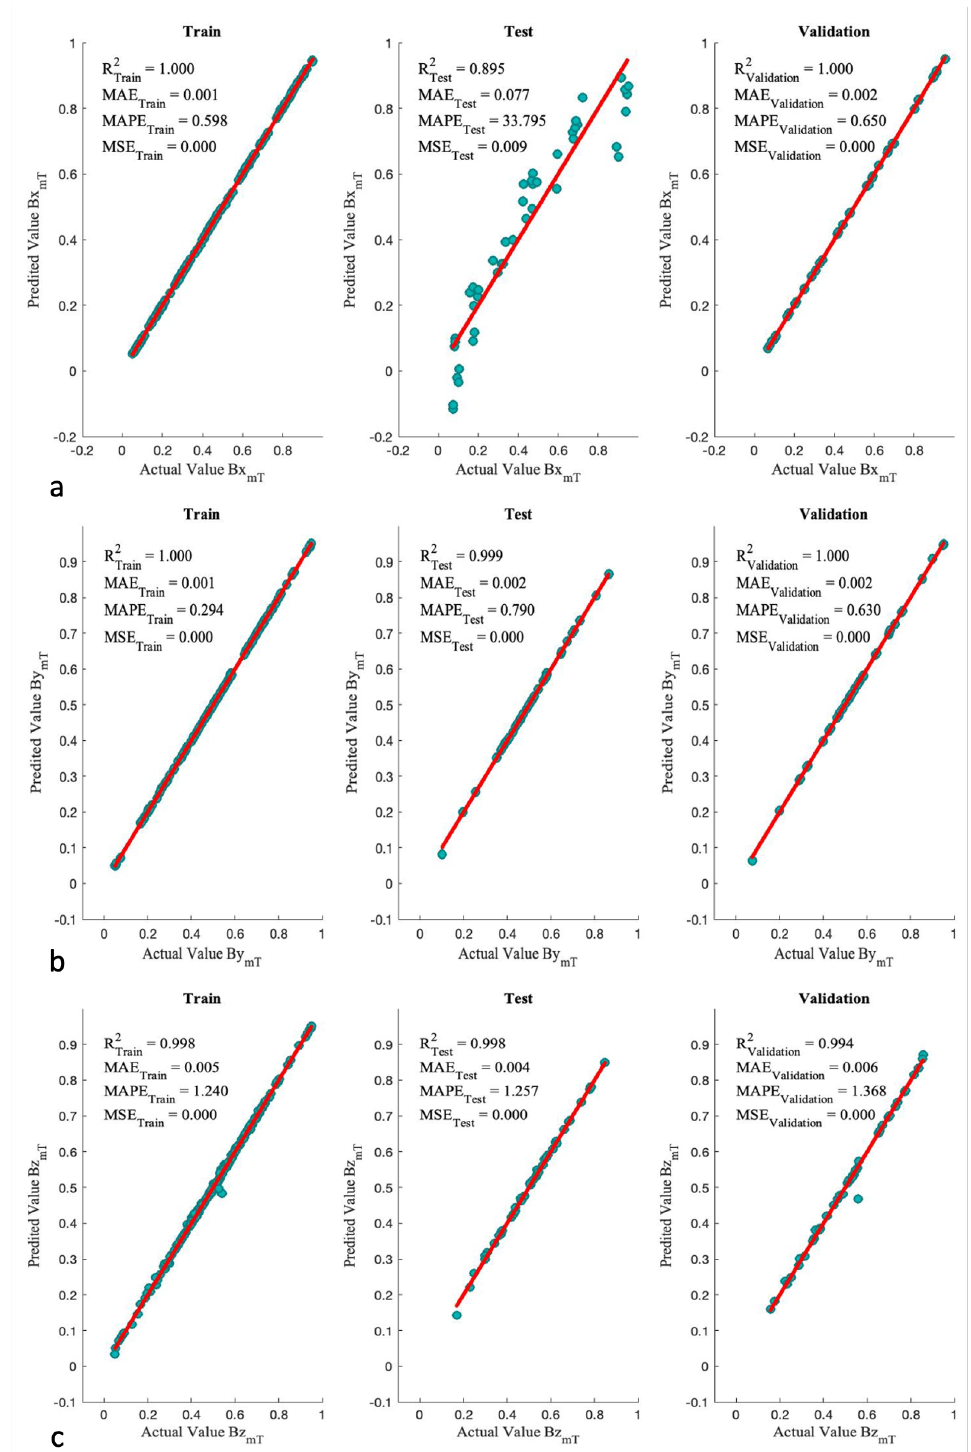
Figure 16. Scatter plot of optimized ANN/SA algorithms for ( a ) B x , ( b ) B y , and ( c ) B z